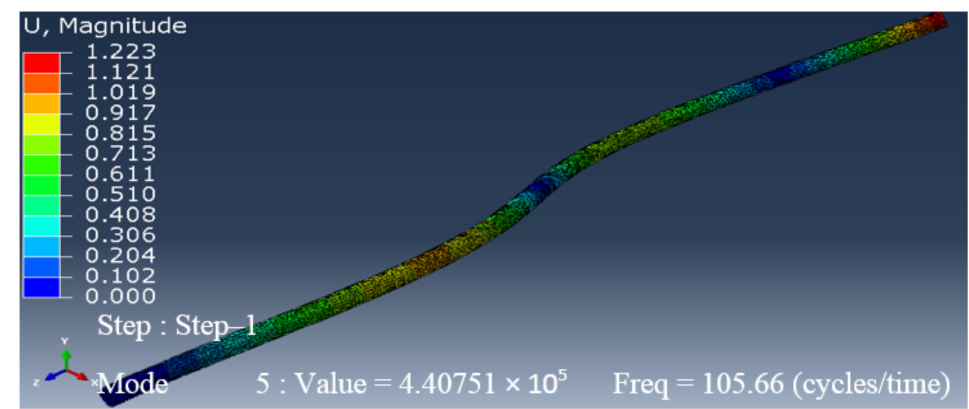
Figure 5. Third natural frequency of an undamaged pipe.